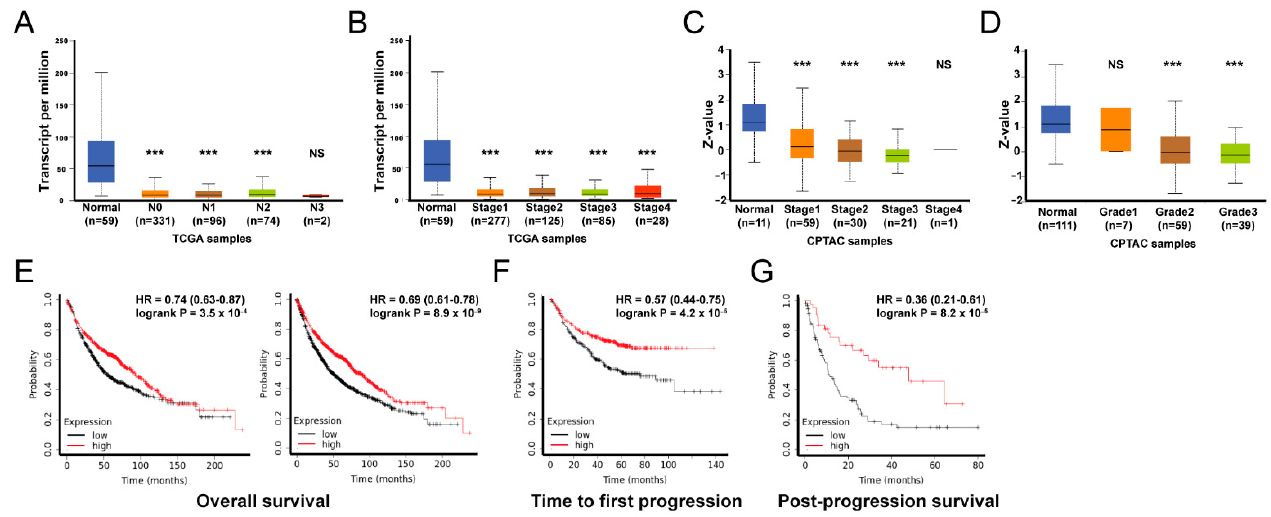
Figure 2. Tumor characteristics and survival analysis of ADAMTS1 expression in LUAD. The mRNA expression of ADAMTS1 among the tumor nodal metastasis ( A ) and stages ( B ) in the TCGA cohort. The protein expression among the tumor stages ( C ) and grade ( D ) in the CPTAC cohort. Overall survival (OS) ( E ), time to first progression (FP) ( F ), and post-progression survival (PPS) ( G ) with ADAMTS1 expression level were analyzed using Kaplan–Meier methods in the public microarray and TCGA dataset. (*** p < 0.005).